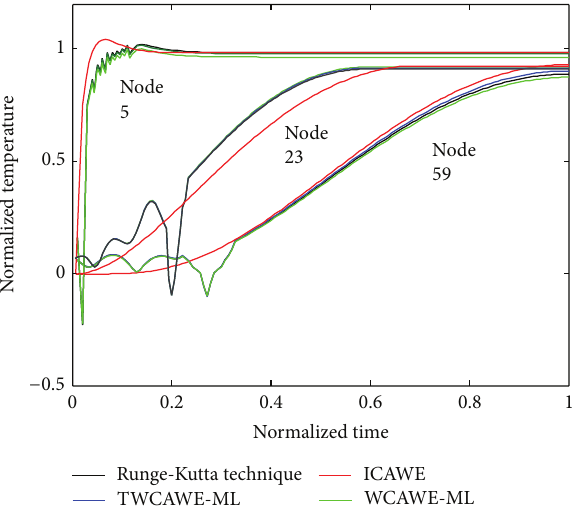
Figure 7: Comparison of TWCAWE-ML, WCAWE-ML, and ICAWE for 𝑍 𝑇 = 0.0001 .